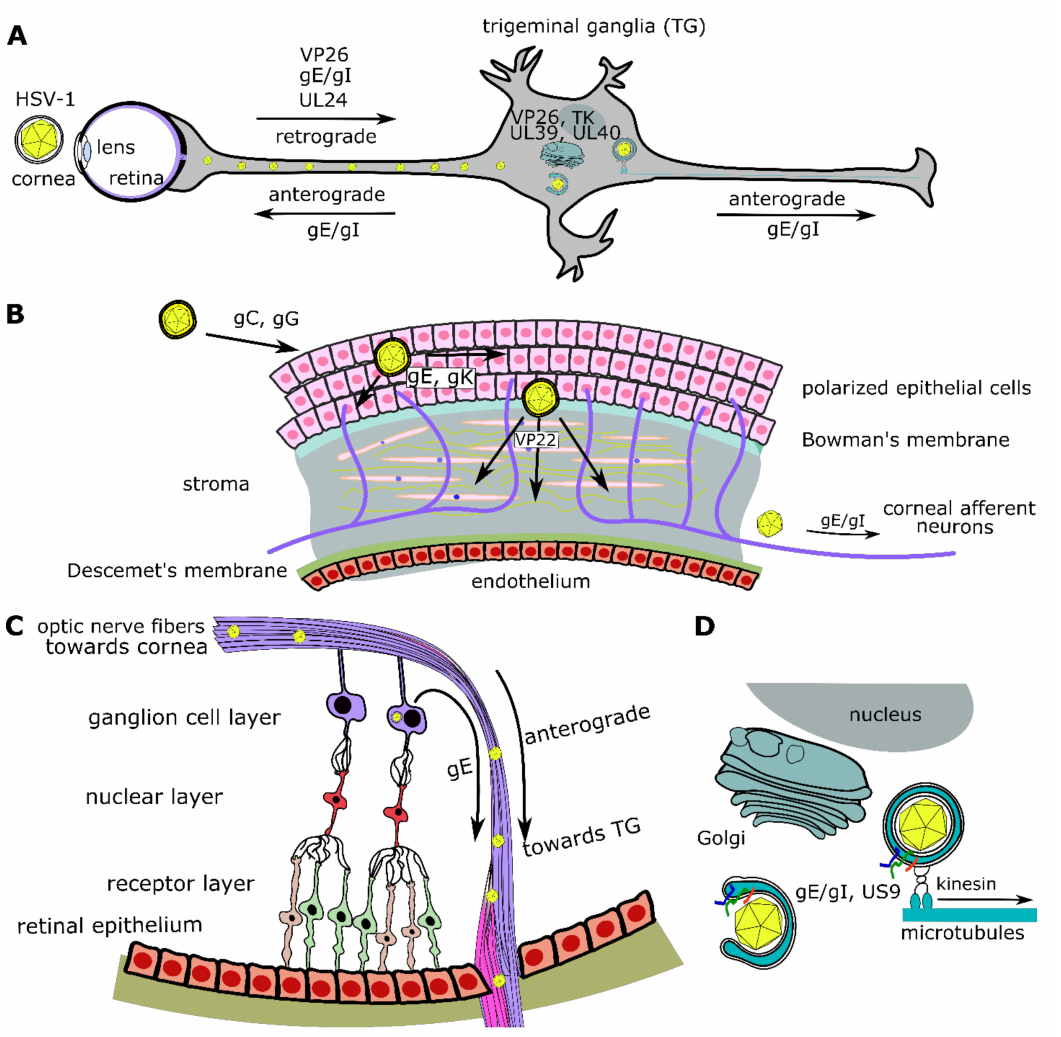
Figure 4. HSV-1 ocular infection based on data in mouse models. ( A ) HSV-1 can infect the eye through the cornea, where it can establish a productive infection in the corneal epithelium. The virus can then spread through the innervating sensory neurons to the trigeminal ganglia (TG), moving retrograde along axons towards the neuronal bodies. VP26 mediates migration to the TG. gE/gI and U L 24 are important for trafficking of the virion along the axons towards the neuronal bodies. U L 39/U L 40 and TK are required for replication in cells that do not actively divide, such as neurons. gE/gI affect both retrograde and anterograde movement of the virion. ( B ) HSV-1 infection of the cornea: The virus can infect the upper layer of polarized epithelial cells, which requires gC and gG. Dissemination of the ocular infection requires the function of gE and gK, and further spread of the virus towards the underlying stromal layers of the cornea requires the function of VP22. HSV-1 can infect corneal afferent neurons and then spread towards the TG utilizing gE/gI. ( C ) HSV-1 can establish an infection in the retinal neuronal cells and can then move retrograde towards the cornea or anterograde towards the central nervous system (CNS). This migration requires gE, and presumably gI since they function in a complex. ( D ) Anterograde trafficking of virions inside neurons requires gE/gI and U S 9. Based on data in pseudorabies virus (PRV), U S 9 interacts with kinesins that regulate the anterograde movement of virions along microtubules towards axonal termini. It is also possible that gE/gI and U S 9 are required for proper cytoplasmic envelopment and sorting to